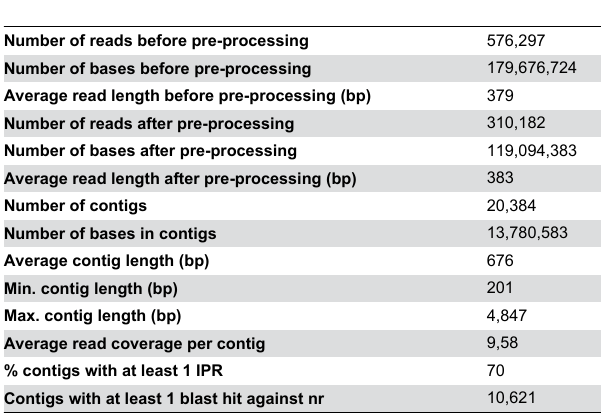
Table 1. Summary of Anthonomus grandis transcriptome sequencing assembly and annotation.